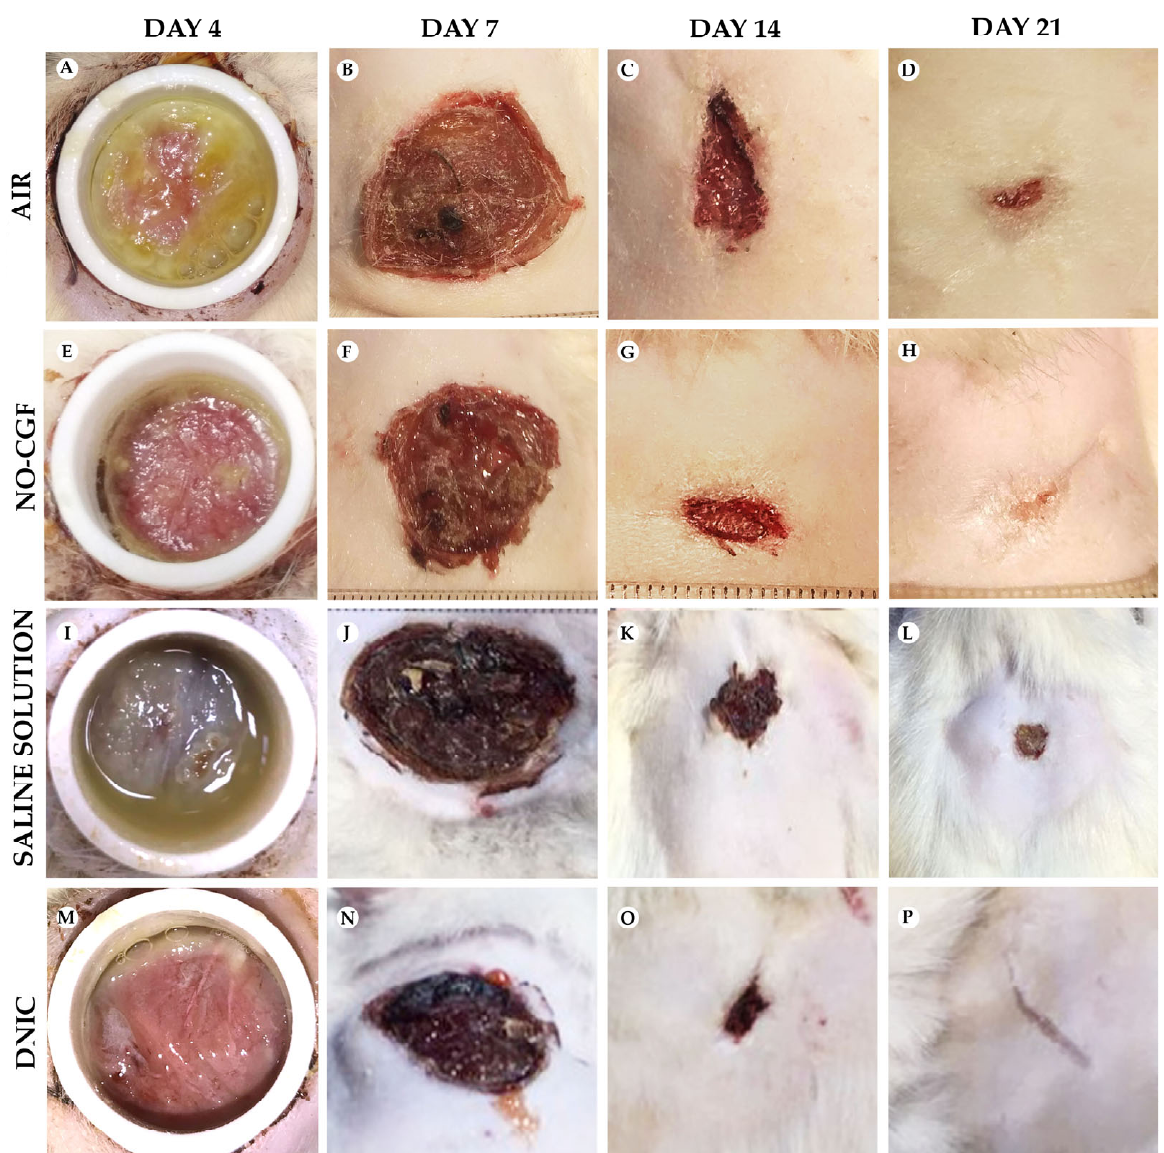
Figure 1. Gross examination of wounds in animals on post-operative days 4 ( A , E , I , M ), 7 ( B , F , J , N ), 14 ( C , G , K , O ) and 21 ( D , H , L , Р ).